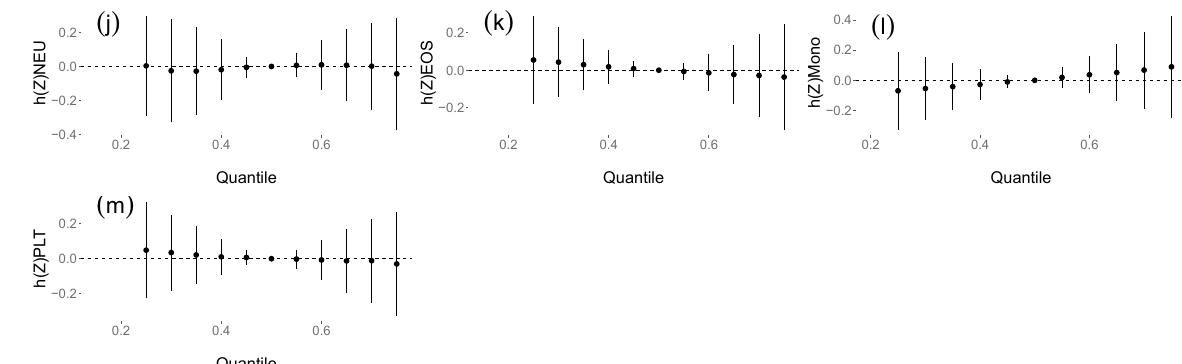
Figure 1. Overall effect (95% CI) of exposure to the insecticide mixture on haemoglobin (Hb) ( a ), haematocrit (Hct) ( b ), mean corpuscular volume (MCV) ( c ), mean corpuscular haemoglobin (MCH) ( d ), mean corpuscular haemoglobin concentration (MCHC) ( e ), red cell distribution width (RDW) ( f ), red blood cell (RBC) count ( g ), white blood cell (WBC) count ( h ), lymphocyte (LYM) ( i ), neutrophil (NEU) ( j ), eosinophil (EOS) ( k ), monocyte (Mono) ( l ) and platelet (PLT) count ( m ) determined by the Bayesian kernel machine regression (BKMR) model when the concentrations of all the compound and their metabolites were at a particular percentile compared with when the concentrations of all the compound and their metabolites were at the 50th percentile. The models were adjusted for age, ethnicity, education, individual income, smoking status, alcohol consumption, body mass index (BMI), work and exposure characteristics, behaviour during and after working, food consumption and food items consumed in the past month.